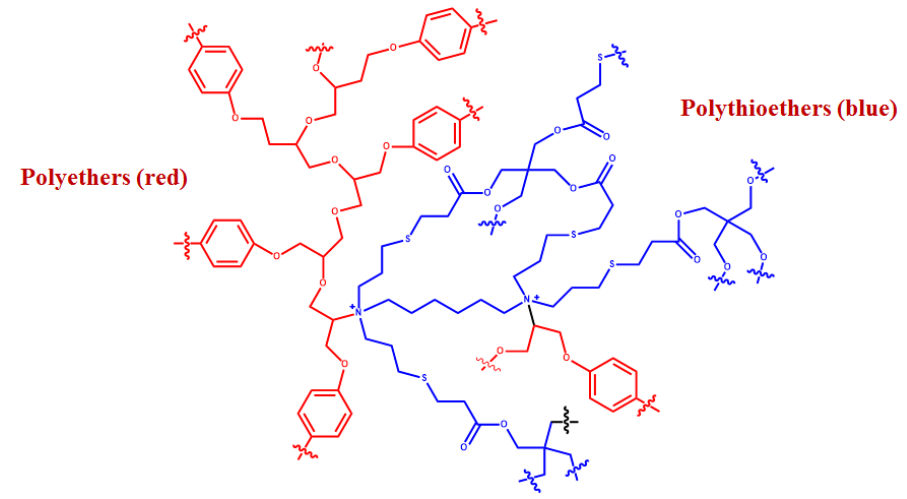
Scheme 4. Simplified representation of the produced polyether – polythioether